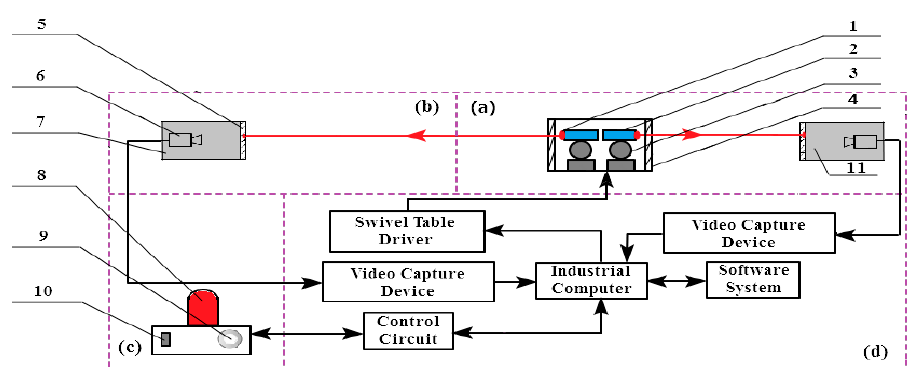
Figure 6. System composition: ( a ) laser transmitter module; ( b ) image acquisition module; ( c ) sound and light alarm module; ( d ) hard devices and system software. 1. forward laser; 2. backward laser; 3. electronically controlled two-dimensional swivel table; 4. organic glass window; 5. filter imaging screen; 6. high-definition industrial camera; 7. darkroom; 8. alarm light; 9. alarm horn; 10. power switch; 11. reference monitoring image acquisition module.